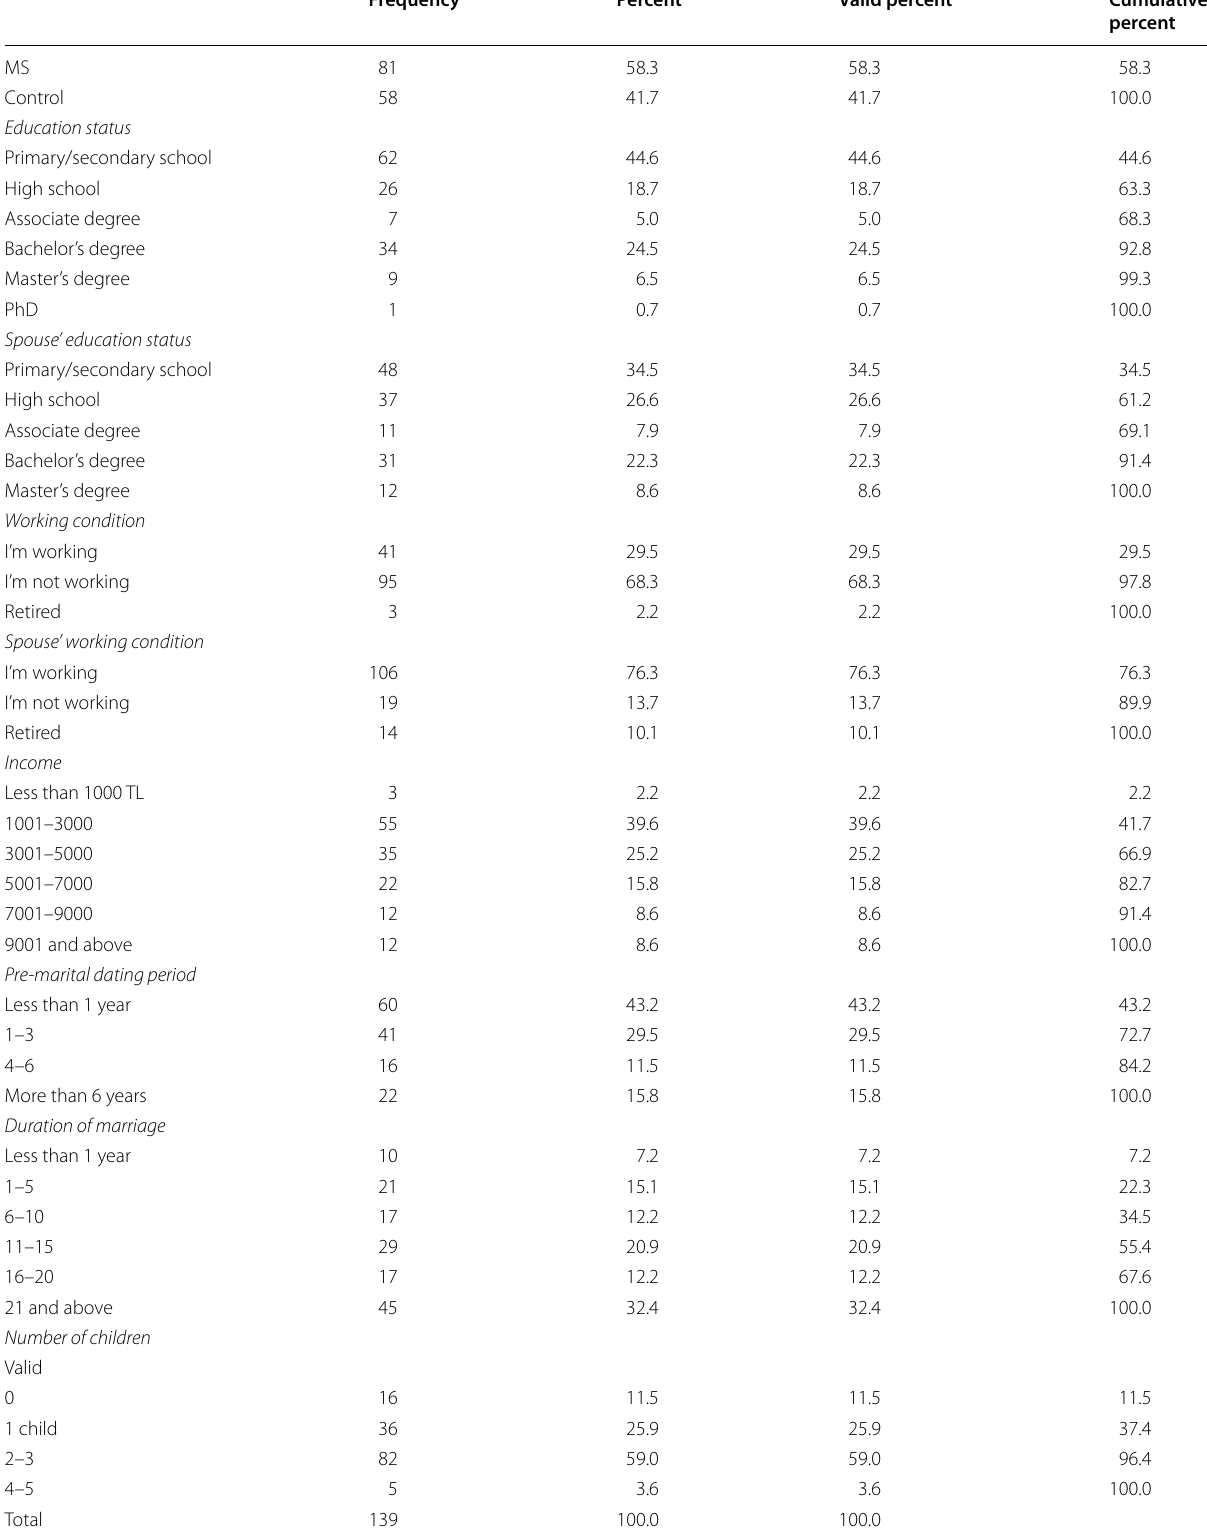
Table 1 Demographic characteristics of